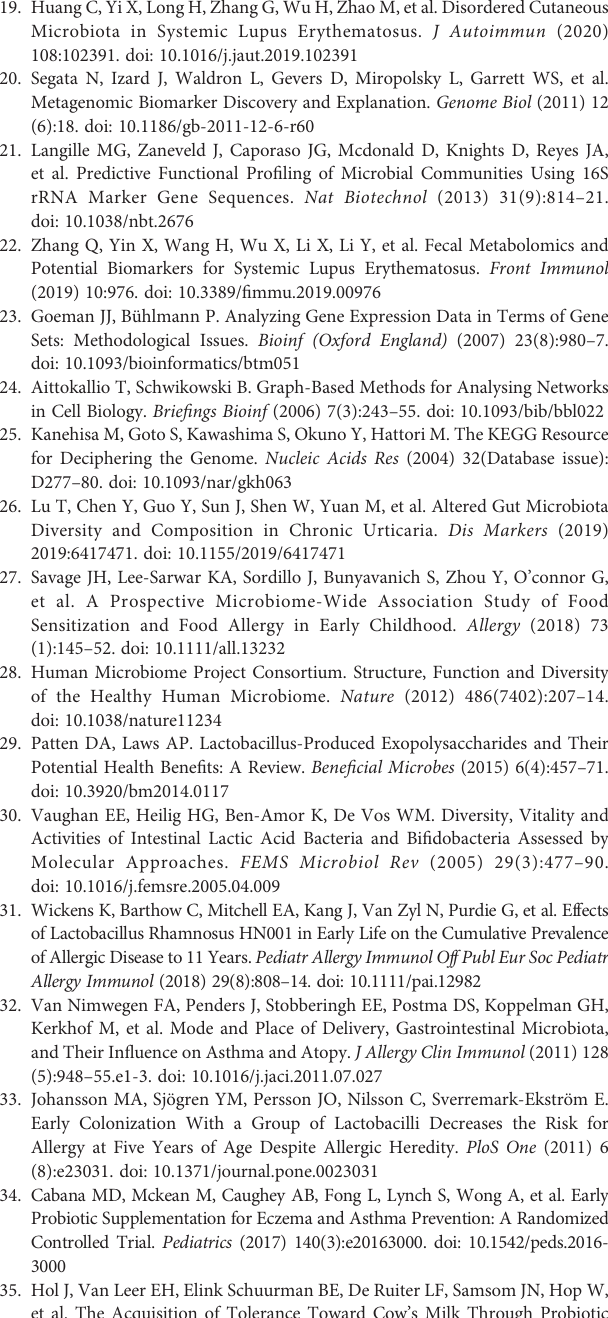
Supplementary Table 4 | The relative abundance of bacterial communities at genus level. Supplementary Table 5 | Linear discriminant analysis (LDA) effect size (LEfSe) between patients with CSU and HCs. Supplementary Table 6 | Predicted metabolic functions of characteristic gut microbiota in patients with CSU.